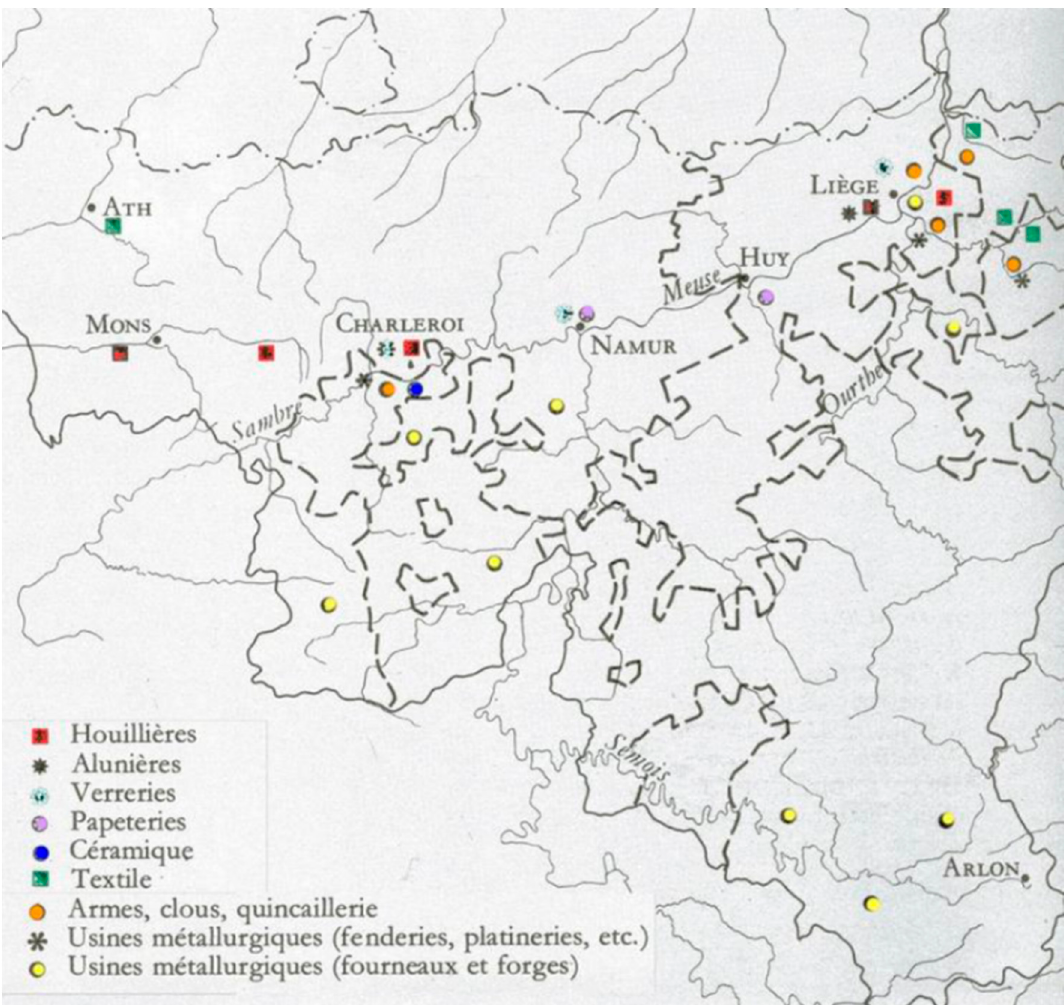
Figure 7. Geographical distribution of Walloon industries, 1680.